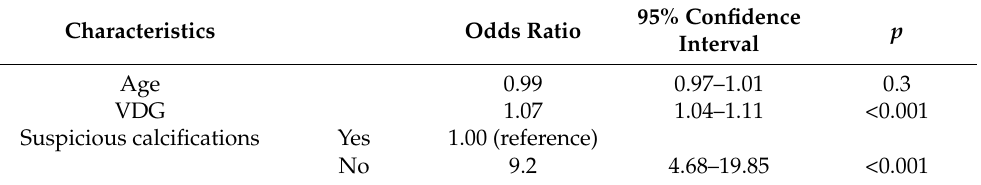
Table 3. Risk factors for non-detected results by MMG (logistic regression